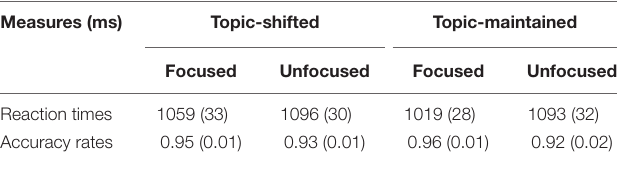
TABLE 3 | Results for the probe-recognition task in Experiment 1 (with standard errors in parentheses). Measures (ms) Topic-shifted